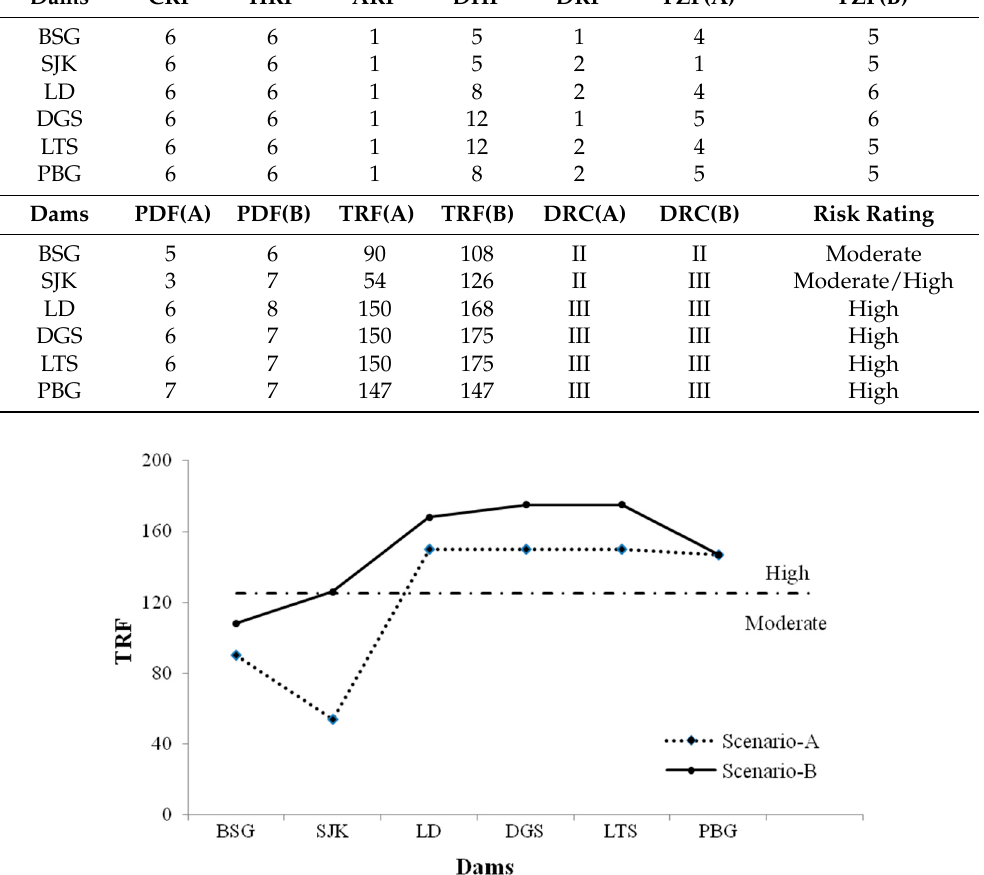
Figure 4. TRFs for the selected dams in both scenarios.